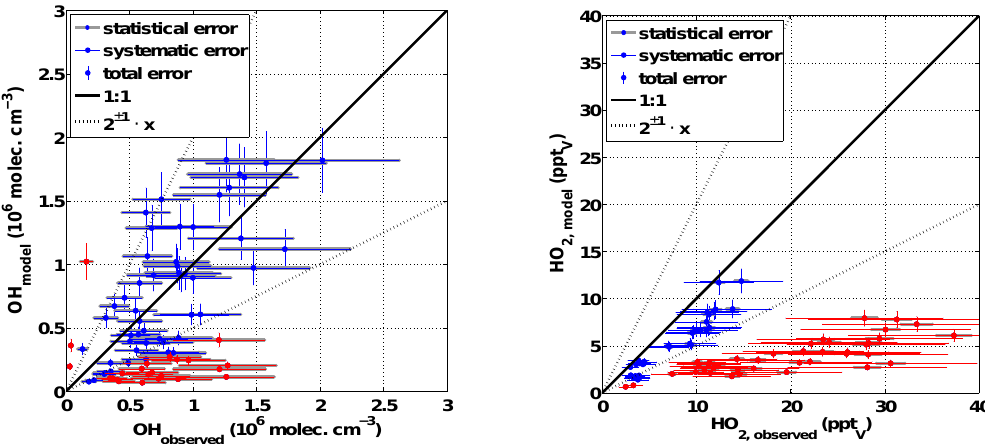
Figure 14. Uncertainties of HO x simulations (using the terpene mechanism) with respect to measurement uncertainties. The solid line represents the 1 : 1 ratio of observed and simulated HO x . Data points showing significant discrepancies within their uncertainties by more than a factor of 2 ± 1 (dashed lines) are shown in red. Table 5. Sensitivity analysis with respect to changes in observed model-constraining parameters. The values presented refer to a data set around local solar noon (13:00 UTC +